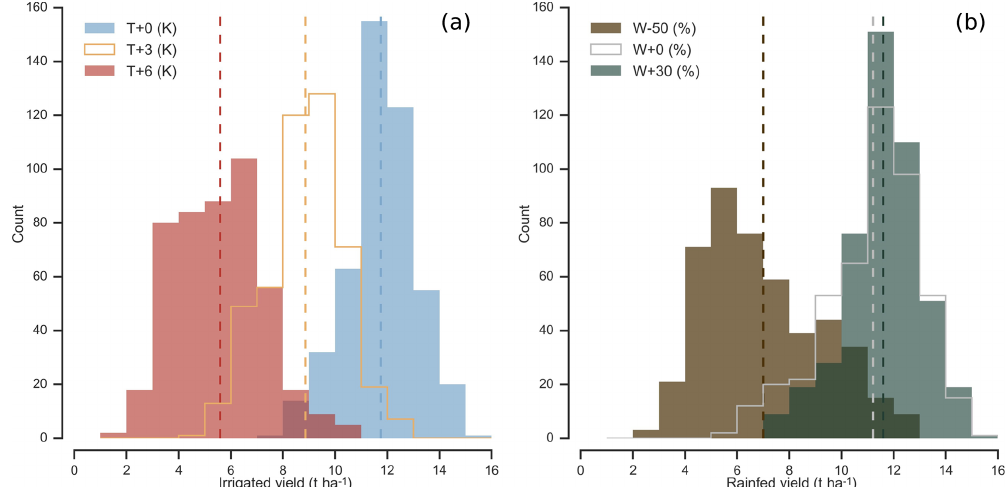
Figure 2. Example showing results of increased crop-yield sensitivity to year-to-year climate variations under climate stress. Yield distribu- tions are from examples in Fig. 1a–b of maize in Iowa (a) for irrigated maize in scenarios of altered temperature and (b) for rainfed maize in scenarios of altered precipitation. Because yield sensitivities rise under strong warming or drying, distributions of year-to-year crop yields widen in T + 6 and P − 50% scenarios relative to present-day simulations, even though all input climate time series have identical variance for temperature. Note that precipitation changes have different variance since the perturbations are